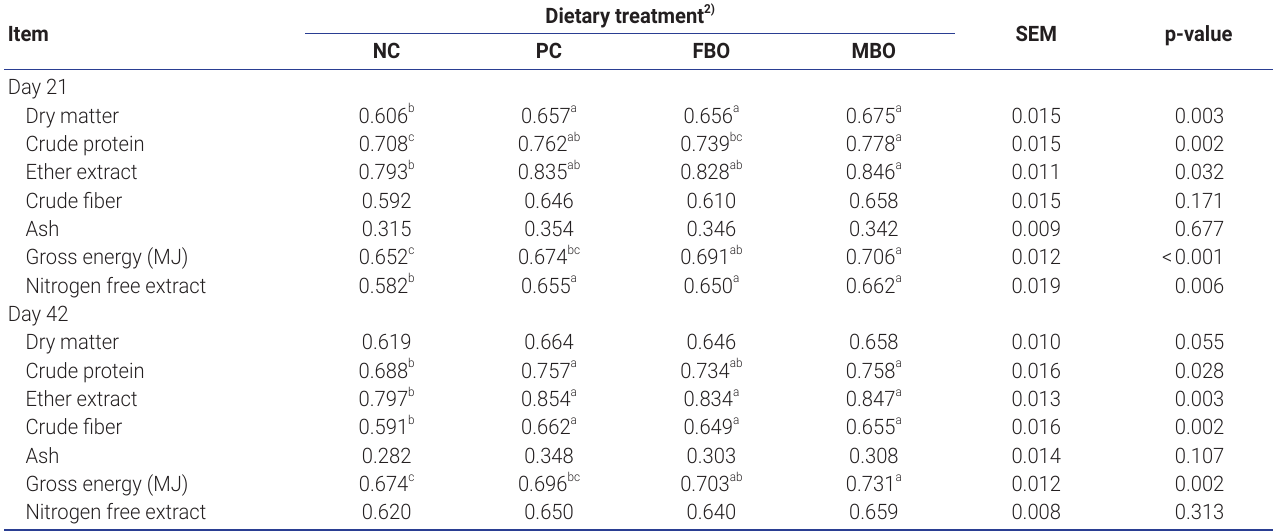
Table 4. Apparent ileal digestibility (AID) of broiler chickens on day 21 and day 42